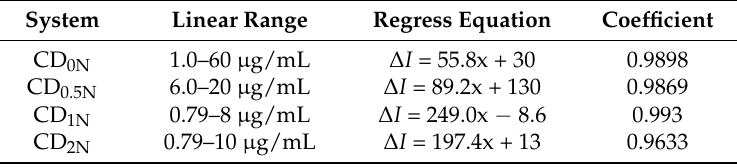
Table 1. Comparing of the catalysis by SERS method a .